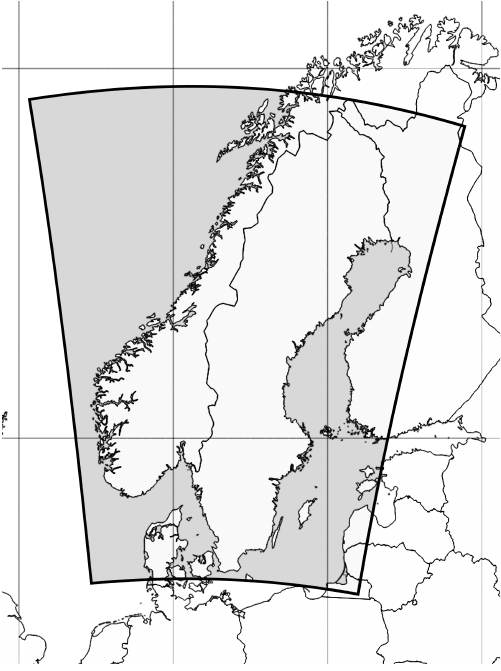
Figure 4. NWP model domain. The domain is centered over Sweden and cover a large part of the rest of